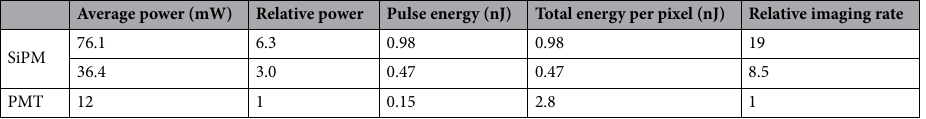
Table 1. Imaging parameters for Fig.